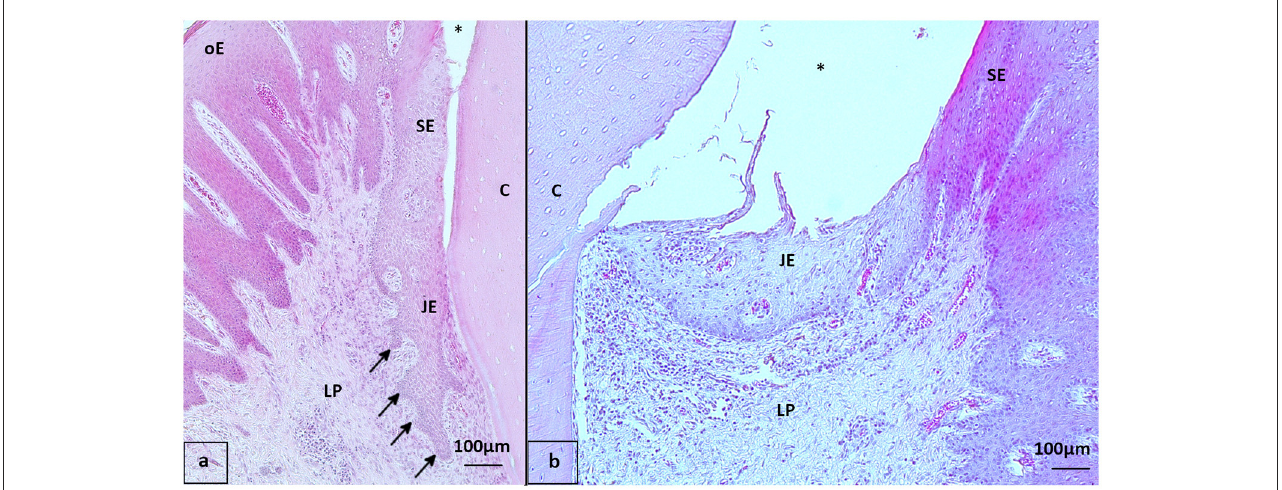
FIGURE3 Gingival sulcus and junctional epithelium with and without rete pegs, staining hematoxylin-eosin (HE) (a, b) oE, Oral epithelium; SE, Sulcular epithelium; JE, Junctional epithelium; LP, Lamina propria; C, Cementum; * Sulcus gingivalis (a) 22-year-old Friesian mare, control, 108 buccal aspect: Rete pegs